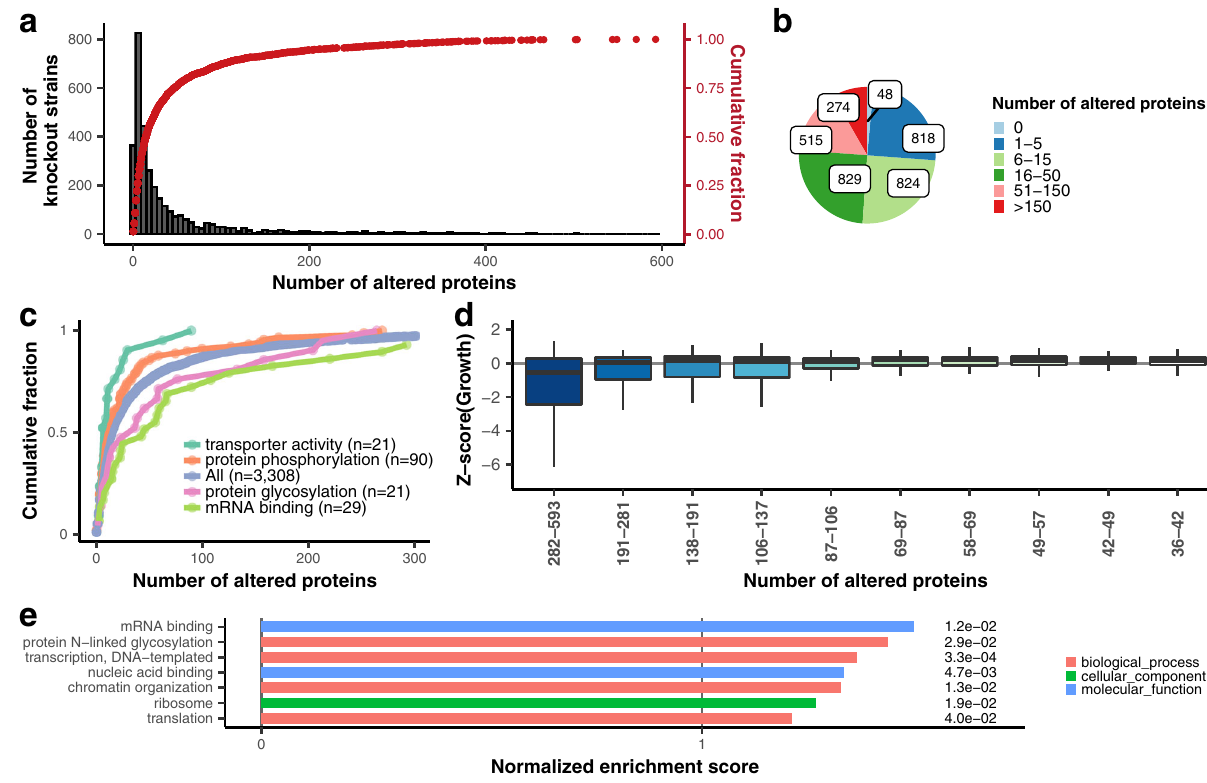
Fig.2|Knockoutstrainswithhighproteomeremodelingtendtohavereduced fi tness and are involved in gene regulation. a Histogram (black) and cumulative scatterplot (red) showing the distribution of the number of altered proteins per strain within the knockout library. b Pie chart of altered proteins per knockout strain. c Analysisofalteredproteinsfordifferentclasses. d Growthbehaviorbinned by the observed number of altered proteins in 33 fractions across all strains illus- trating a signi fi cant growth de fi ciency in strains with extensive proteome